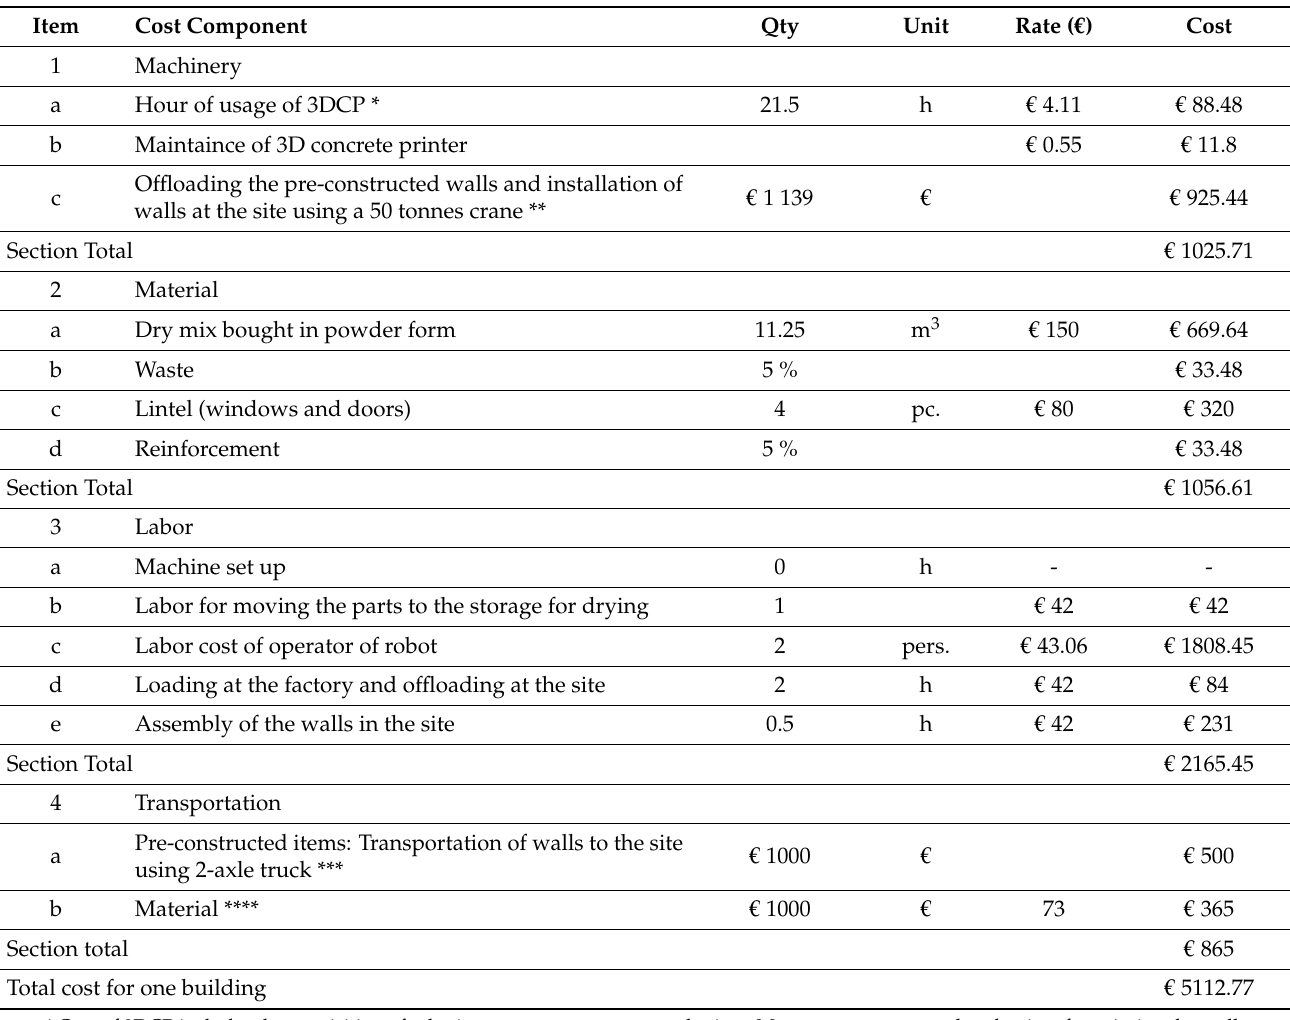
Table A3. Scenario 2 cost model in detail.